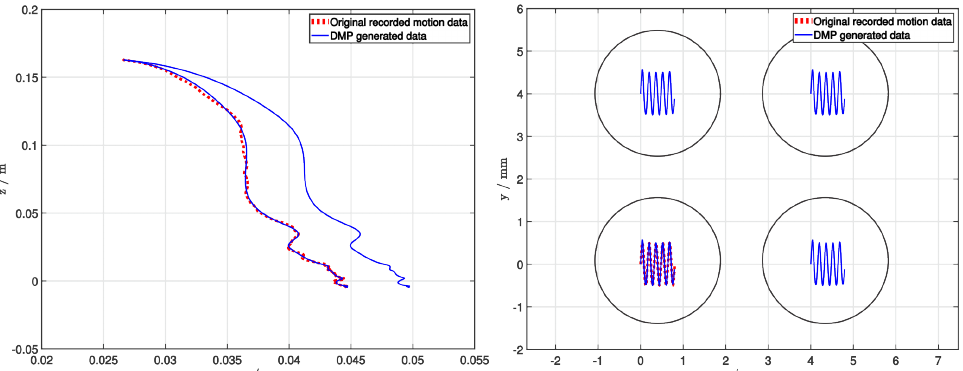
Figure 3. Using DMP to generalize demonstrated trajectories of the picking ( left ) and deposition ( right ) task. In order to demonstrate the quality of generalization, the end position of the picking process is modified, whereas both the start and end position are modified for the deposition